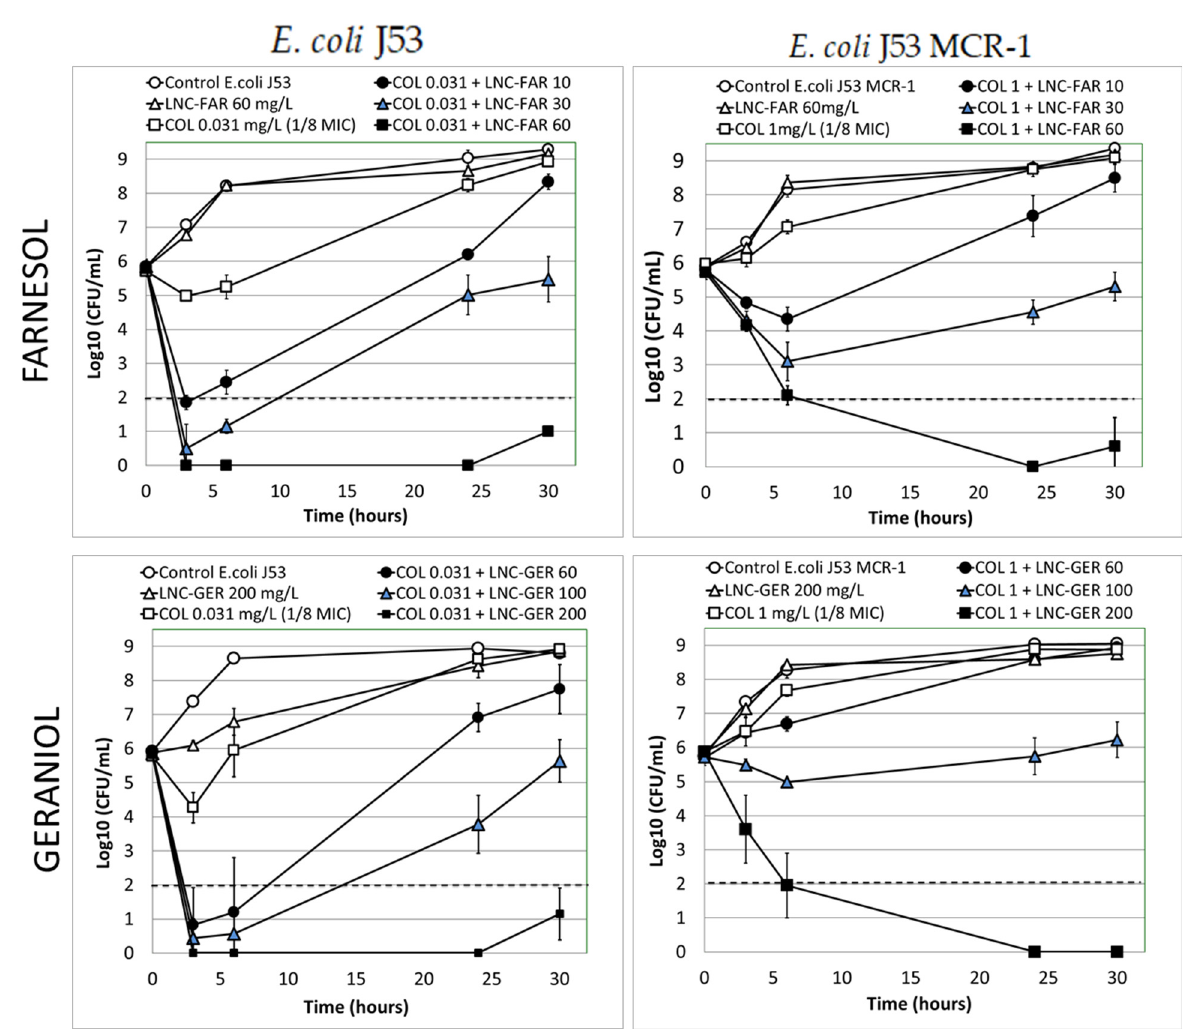
Figure 3. Time-kill curves ( n = 3–6) obtained for E. coli J53 (left panels) and E. coli J53_MCR-1 (right panels) in the presence of colistin base alone at a concentration of 1/8 of its MIC (empty square) or supplemented with FAR-loaded LNP at FAR concentrations of 10, 30, and 60 mg/L (Top plots–solid dots) or supplemented with GER-loaded LNP at GER concentrations of 60, 100, and 200 mg/L (bottom plots–solid dots). Terpene alcohol effect controls were made using the terpene alcohol-loaded LNP alone in the presence of the highest terpene concentration tested (empty triangles). The dotted horizontal line represents the limit of quantification of the bacteria concentration.